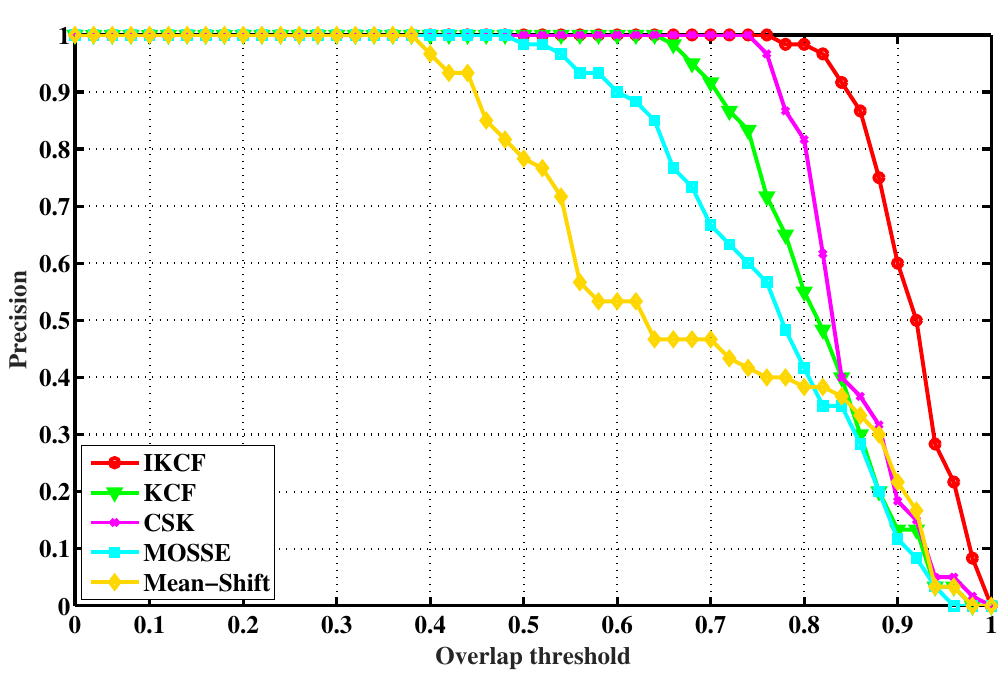
Figure 7. Overlap precision curves (1st frame to 60th